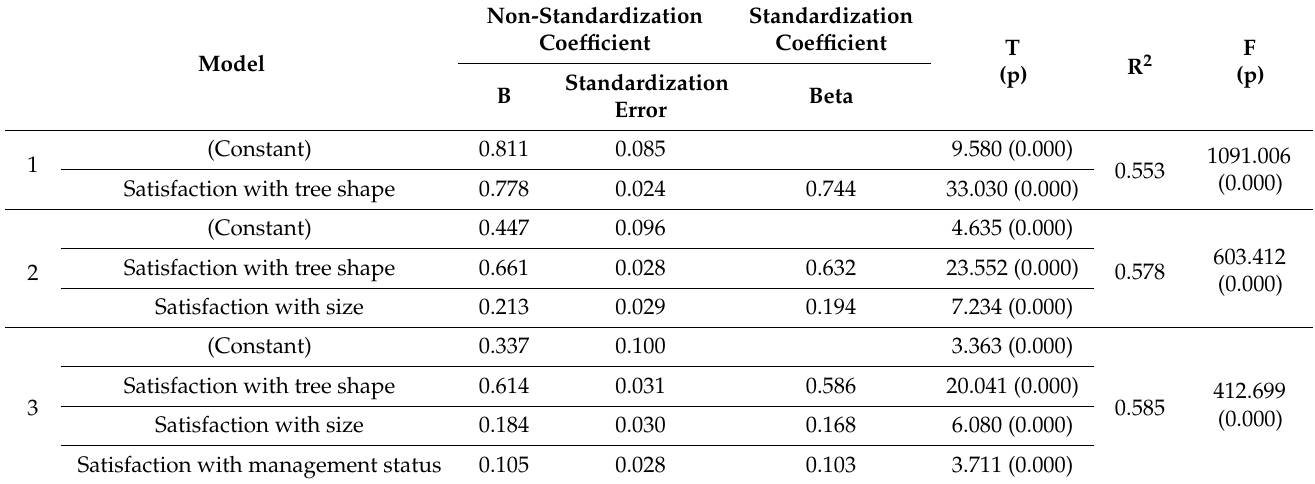
Table 7. Analysis of detailed factors affecting street tree satisfaction using regression